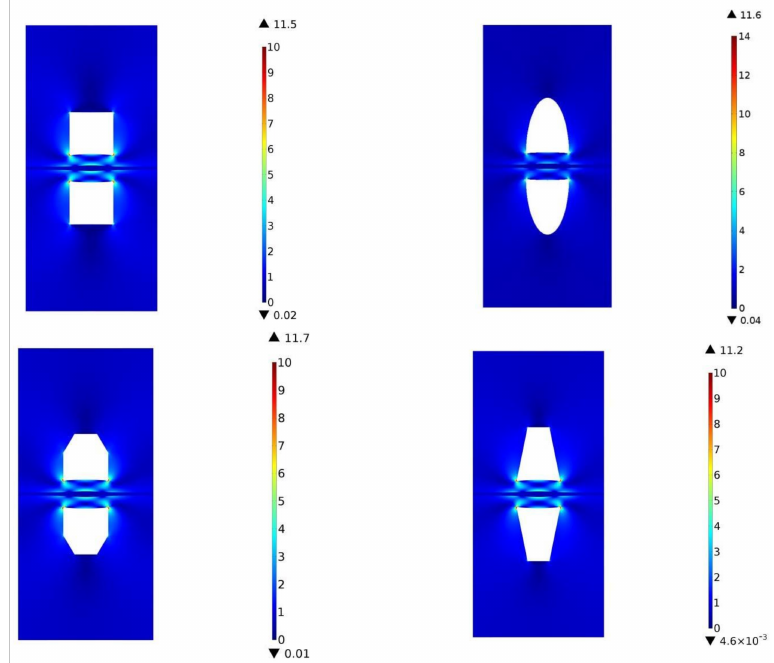
Figure 11. Pressure variations (MPa) in the PEM-FC through the process of assembly at the 1 mm 2 cross-section area with scale increased 50